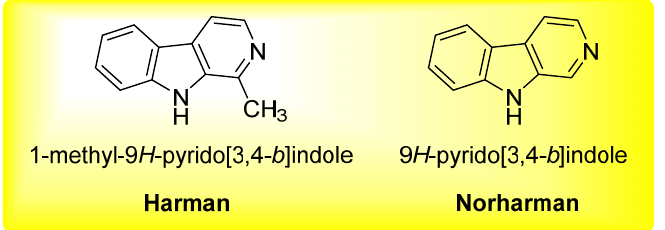
Figure 1. The chemical structure of β -carbolines harman and norharman.